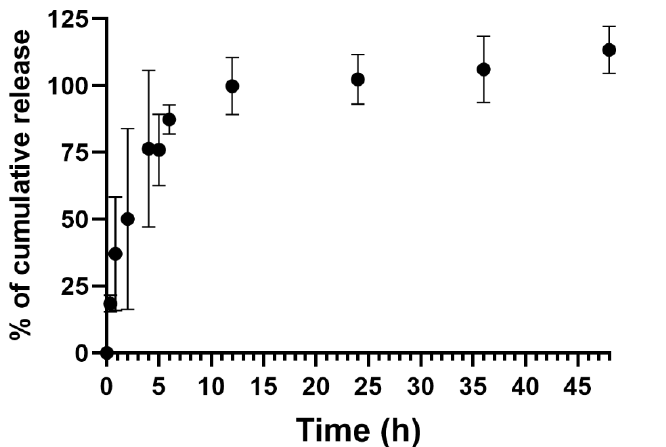
Figure 6. Cumulative release profile of C 8 from the C 8 –aptadendrimer complex. The experiment was performed in 20 mM KPi (pH = 6.9) supplemented with 65 mM KCl for 48 h ( n = 3).